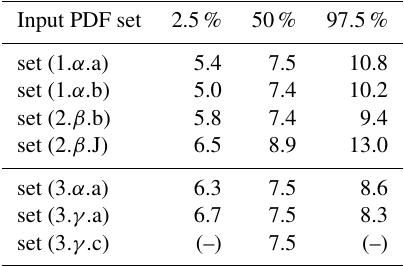
Table 4. The 2.5,%, 50%, and 97.5% quantiles (in kPa) of the fragility curve according to the input PDF reference